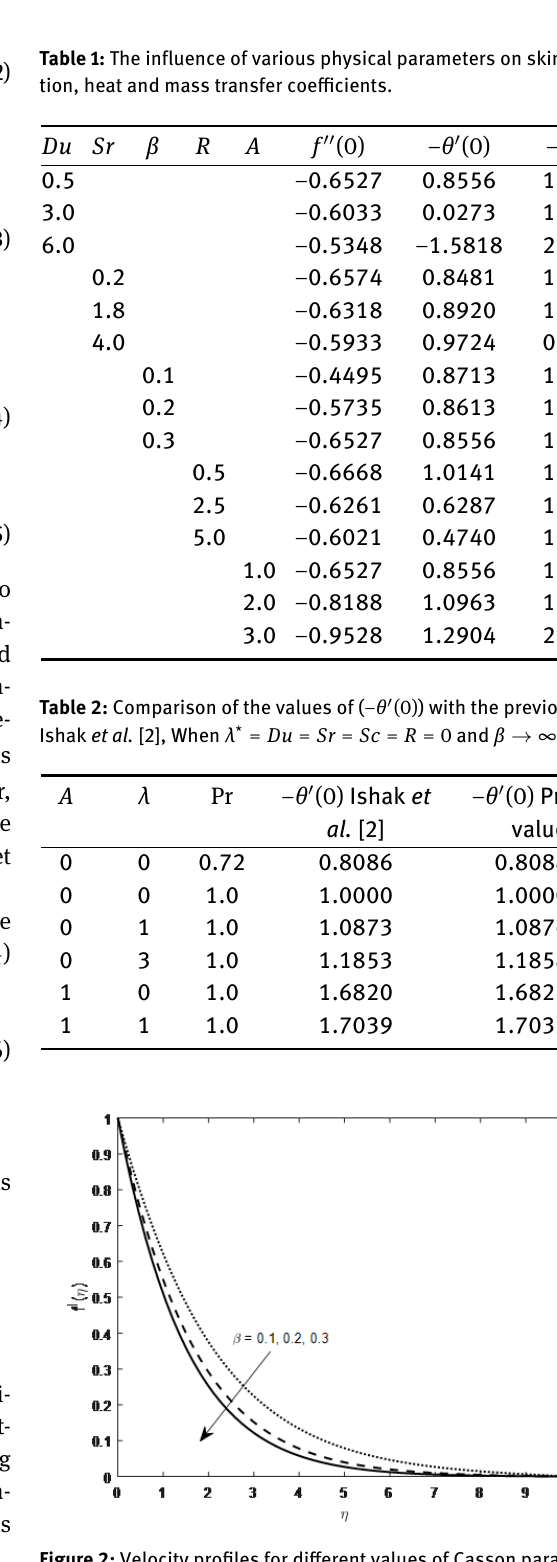
Figure 2: Velocity profiles for different values of Casson parameter